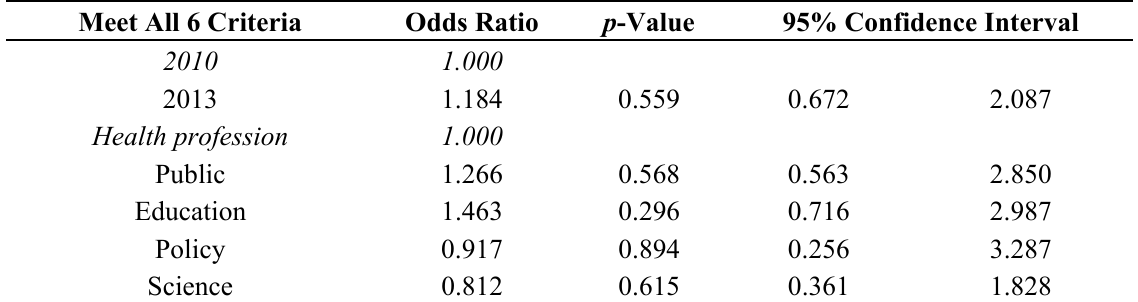
Table 4. Logistic regression model using 2010 and Health Profession as reference